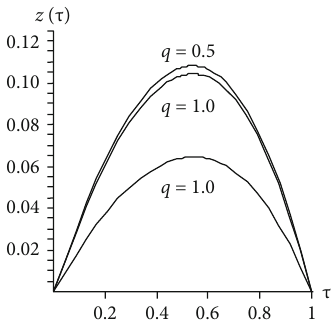
Figure 2: Velocity pro fi le for various values of R with q = 1 : 0 , N = 1 : 0 , A = 1 : 0 , and ji ′ = π /4 .